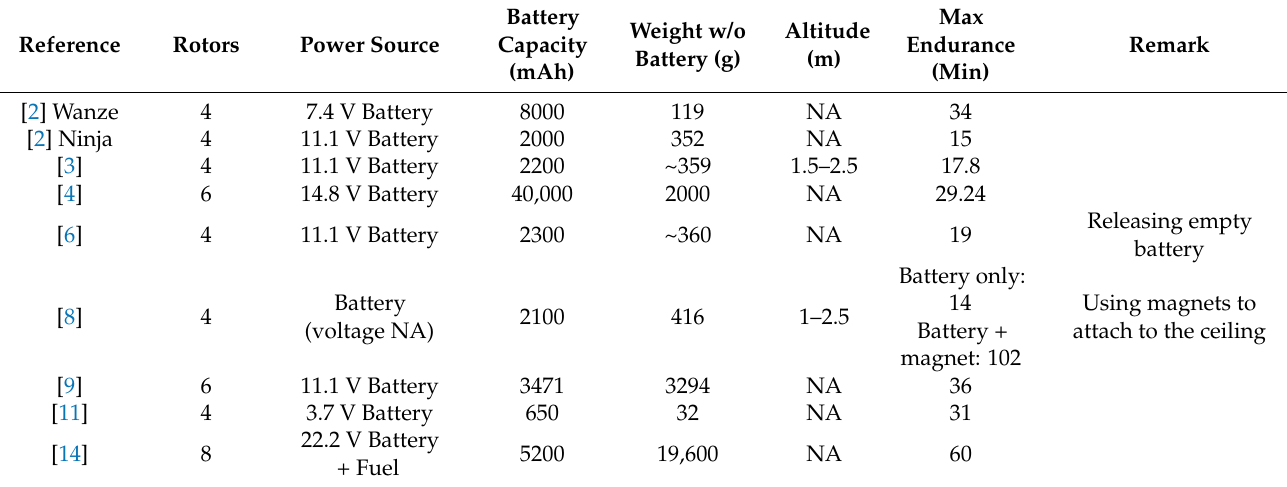
Table 1. Performance of typical battery-powered